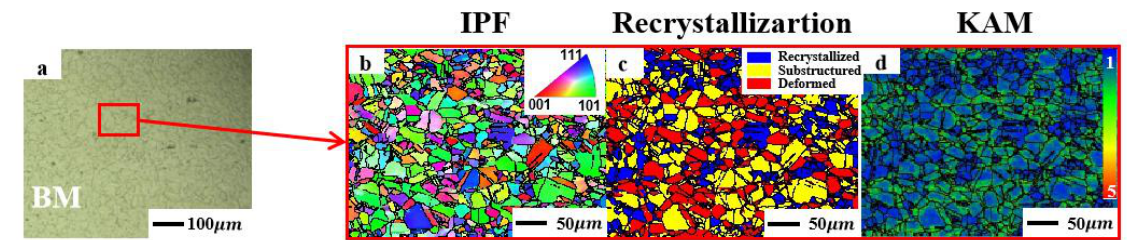
Figure 9. IPF, recrystallization, and KAM diagrams of the original Inconel 625 base metal: ( a ) BM, ( b ) IPF, ( c ) Recrystallizartion, ( d ) KAM. ( b ) IPF, ( c ) Recrystallizartion, ( d )